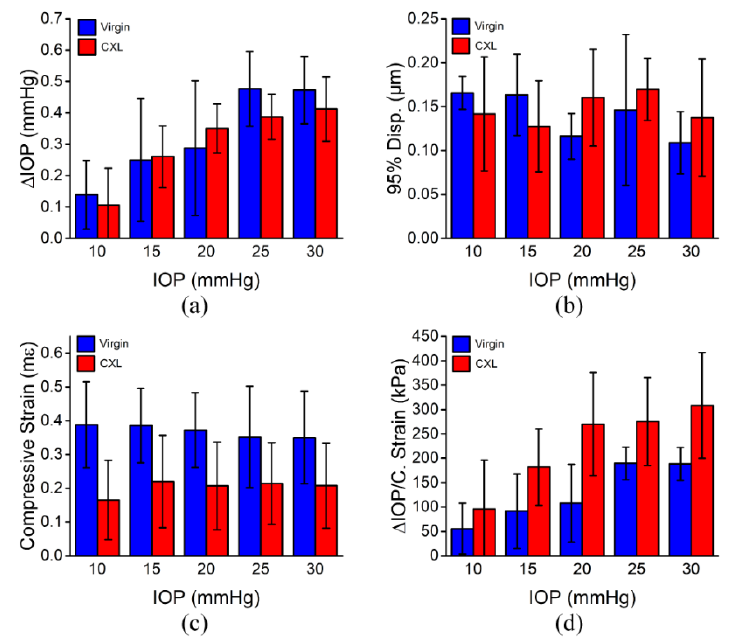
Figure 3. Results of the in situ rabbit corneas (N = 3) as a function of the baseline IOP and before and after CXL. ( a ) The difference in the IOP between the unloaded and loaded states, ( b ) 95th percentile of displacement, ( c ) strain, and ( d ) stiffness as quantified as the ΔIOP/strain as a function of the baseline IOP and before (virgin) and after CXL. The data are presented as the inter-sample means, and the error bars are the inter-sample standard deviation.